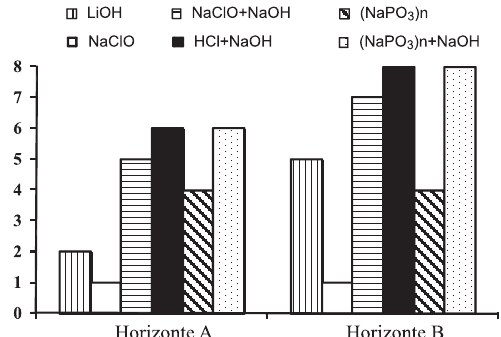
Figura 1. Número de amostras de solo em que os dispersantes alternativos apresentaram resposta igual à do dispersante de referência (NaOH) na determinação do teor de argila (avaliações com dispersantes alternativos: total = 96, sendo 48 por horizonte e 8 por